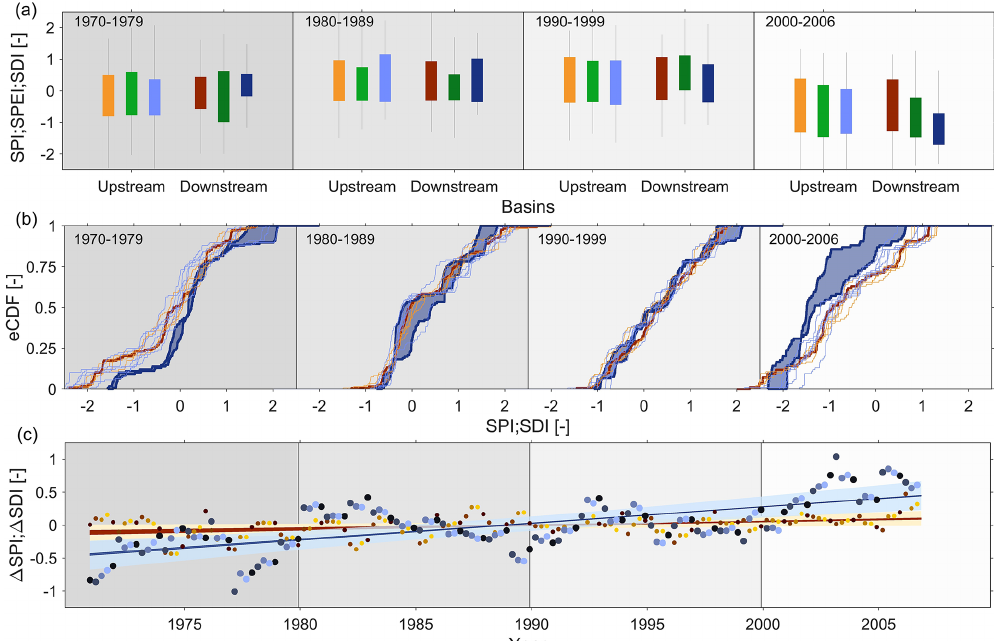
Figure 8. (a) Decadal distributions of the SPI, SPEI, and SDI for the most-upstream sub-basins (ID1–ID6) and the downstream sub-basins (ID7–ID8); (b) decadal empirical cumulative distribution functions of the SPI (thin red lines: upstream basins; bold red lines: downstream basins) and SDI (thin blue lines: upstream basins; bold blue lines: downstream basins). Note that the blue shaded area is added for better visualization of the shifts in downstream basins only and does not have a specific meaning. (c) Time series of differences between the mean upstream and mean downstream SPI ( (cid:49) SPI: yellow and red shades) as well as between the mean upstream and mean downstream SDI ( (cid:49) SDI: blue shades). The symbols with shades from dark to light indicate the monthly SPI values (based on a 12-month accumulation period) for the months January, April, July, and October, respectively. The dark shaded areas indicate the envelope of trends in (cid:49) SPI and (cid:49) SDI, respectively, estimated based on the months of January, April, July, and October, respectively. The light shaded areas show the associated envelope of the 5th and 95th confidence